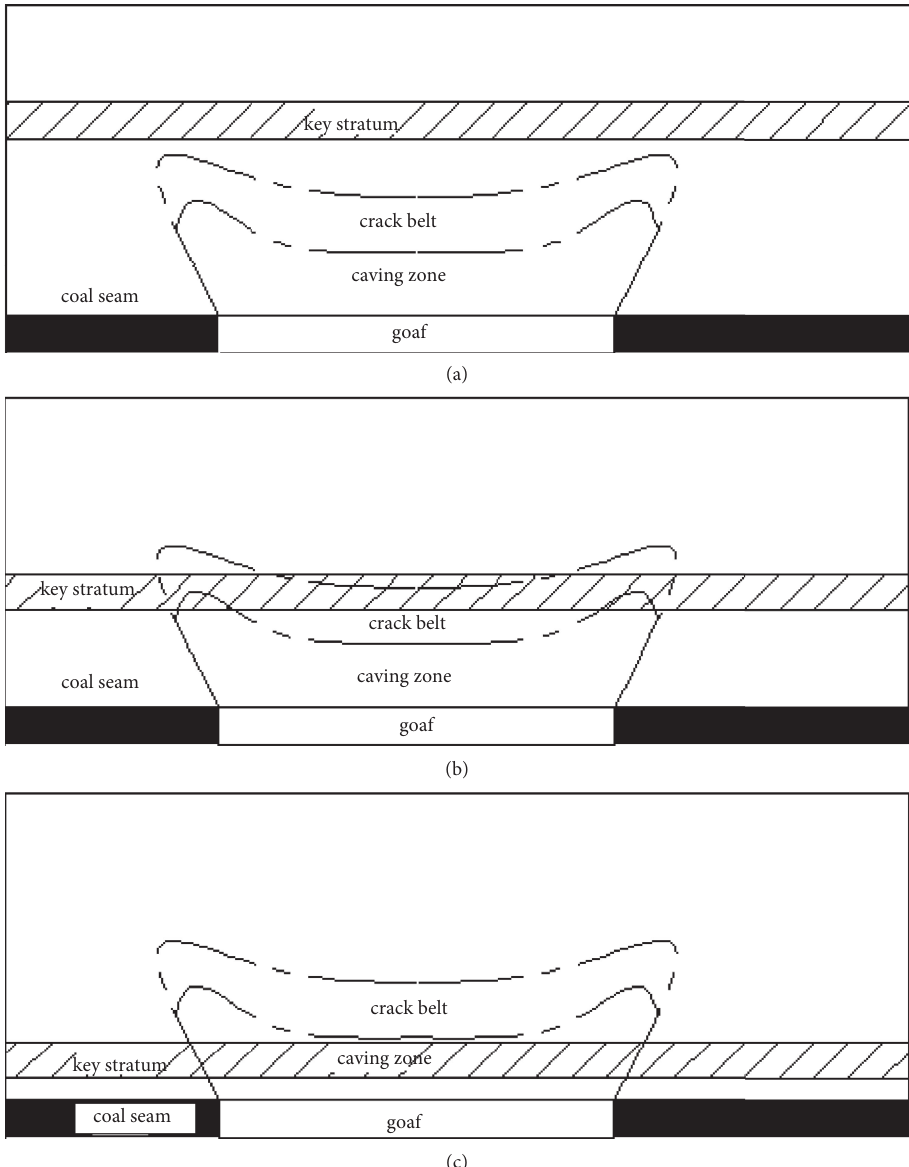
Figure 5: Test plan design: (a) the main key stratum is located in the “original crack belt”; (b) the main key stratum is located in the “original crack belt boundary”; (c) the main key stratum is located in the “original caving zone”.